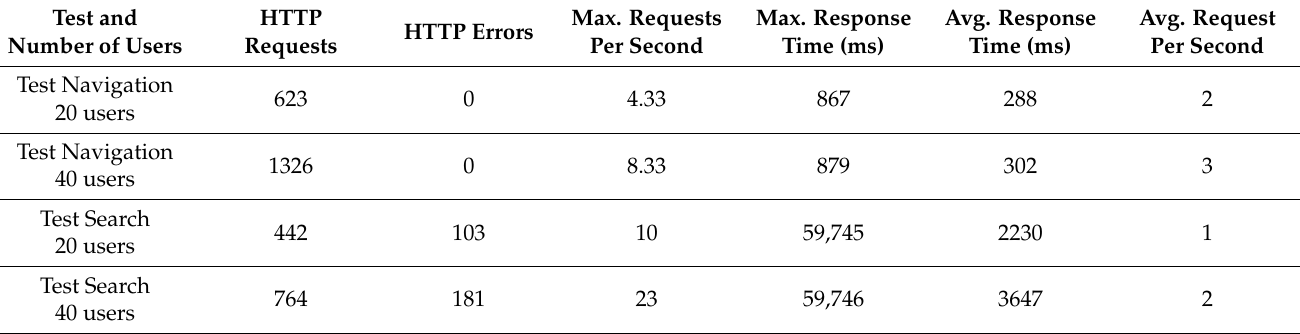
Table 4. Summary of the results of the stress tests considering both 20 and 40 users.